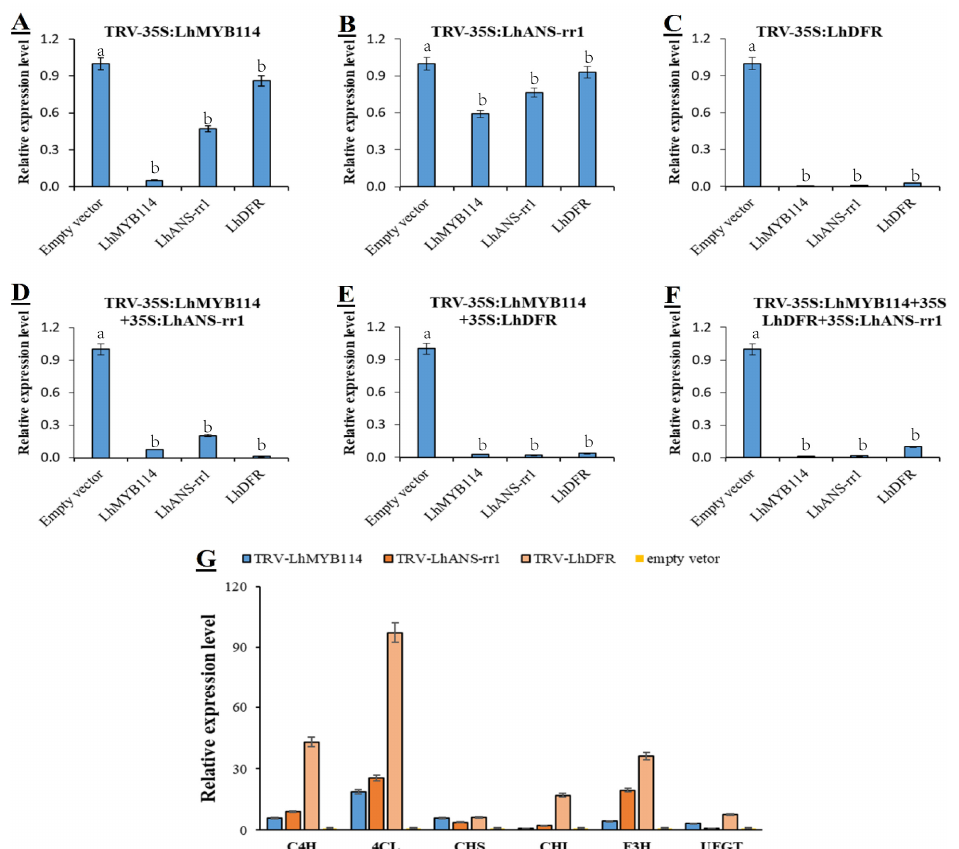
Figure 8. Relative expression levels of three key genes under different VIGS treatments. ( A ) Down- regulation of LhANS-rr1 and LhDFR expression in LhMYB114 -silenced bud. ( B ) Down-regulation of LhMYB114 and LhDFR expression in LhANS-rr1 -silenced bud. ( C ) Down-regulation of LhANS-rr1 and LhMYB114 expression in LhDFR -silenced bud. ( D ) Down-regulation of LhMYB114 , LhANS-rr1 and LhDFR expression in LhMYB114 + LhANS-rr1 -silenced bud. ( E ) Down-regulation of LhMYB114 , LhANS-rr1 and LhDFR expression in LhMYB114 + LhDFR -silenced bud. ( F ) Down-regulation of LhMYB114 , LhANS-rr1 and LhDFR expression in LhMYB114 + LhDFR + LhANS-rr1 -silenced bud. ( G ) The six main genes ( C4H , 4CL , CHS , CHI , F3H, and UFGT ) expressed in TRV- LhMYB114 , TRV- LhANS-rr1 , TRV- LhDFR , and empty vector. The values are means ± SDs ( n = 3). Lowercase letters (a − f) indicate statistically significant differences at p < 0.05.